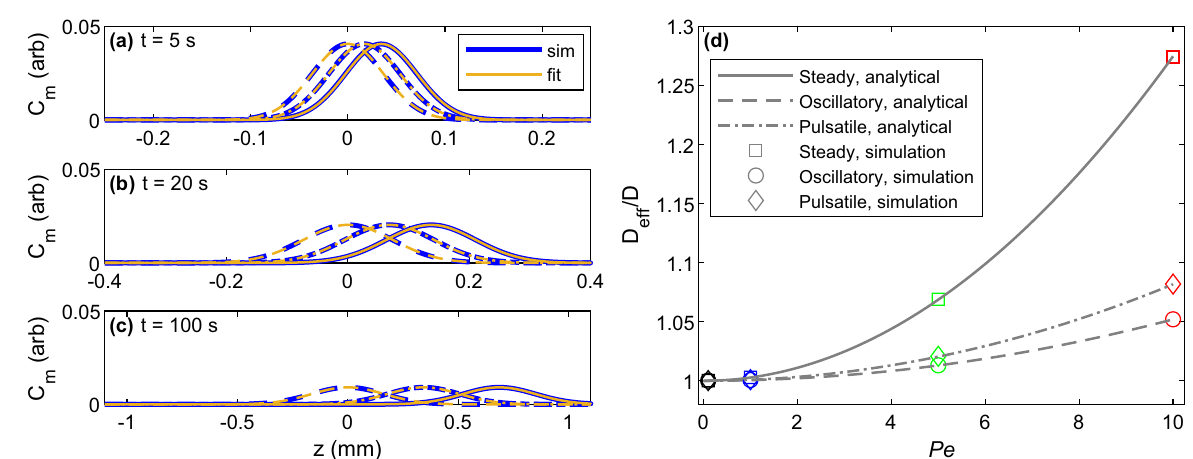
Figure 2. Snapshots of solute concentration fields for three different flow types with Pe ( a – e ) Concentration fields for ( a ) the initial condition, ( b ) pure diffusion, and ( c ) steady, ( d ) oscillatory, and ( e ) pulsatile Poiseuille flow. ( f ) Radially-averaged concentration profiles for the initial condition and steady, oscillatory, and pulsatile Poiseuille flow. Flows with faster steady components exhibited greater displacement of the peak concentration, as well as slightly lower peaks and wider solute distributions. Note that the initial condition shown in panels ( a , f ) has a peak concentration of 1 which extends beyond the colorbar/y-axis limit of 0.04. An animation of this figure, without the pure diffusion case, is provided in Supplementary Video 1.